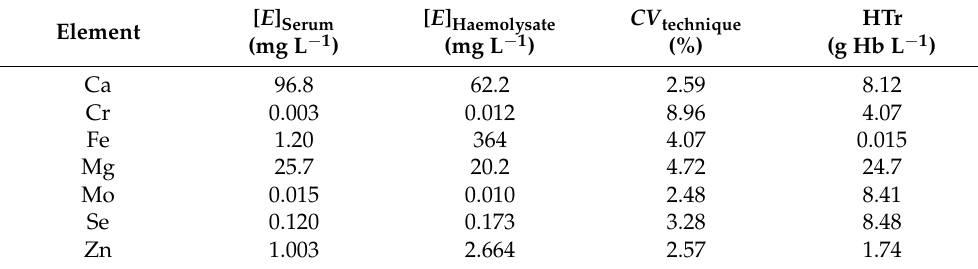
Table 3. Estimation of the haemolysis threshold (HTr) affecting serum mineral element concentrations (only for those elements showing statistically significant differences between whole blood and serum